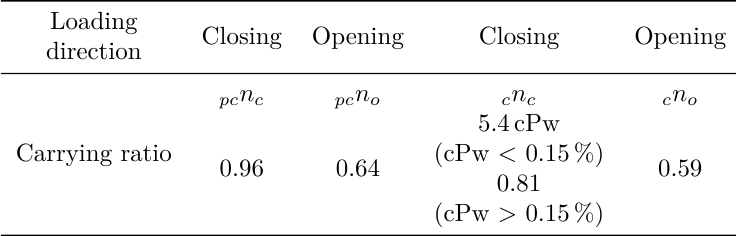
Table 5. Carrying stress coe ffi cient.